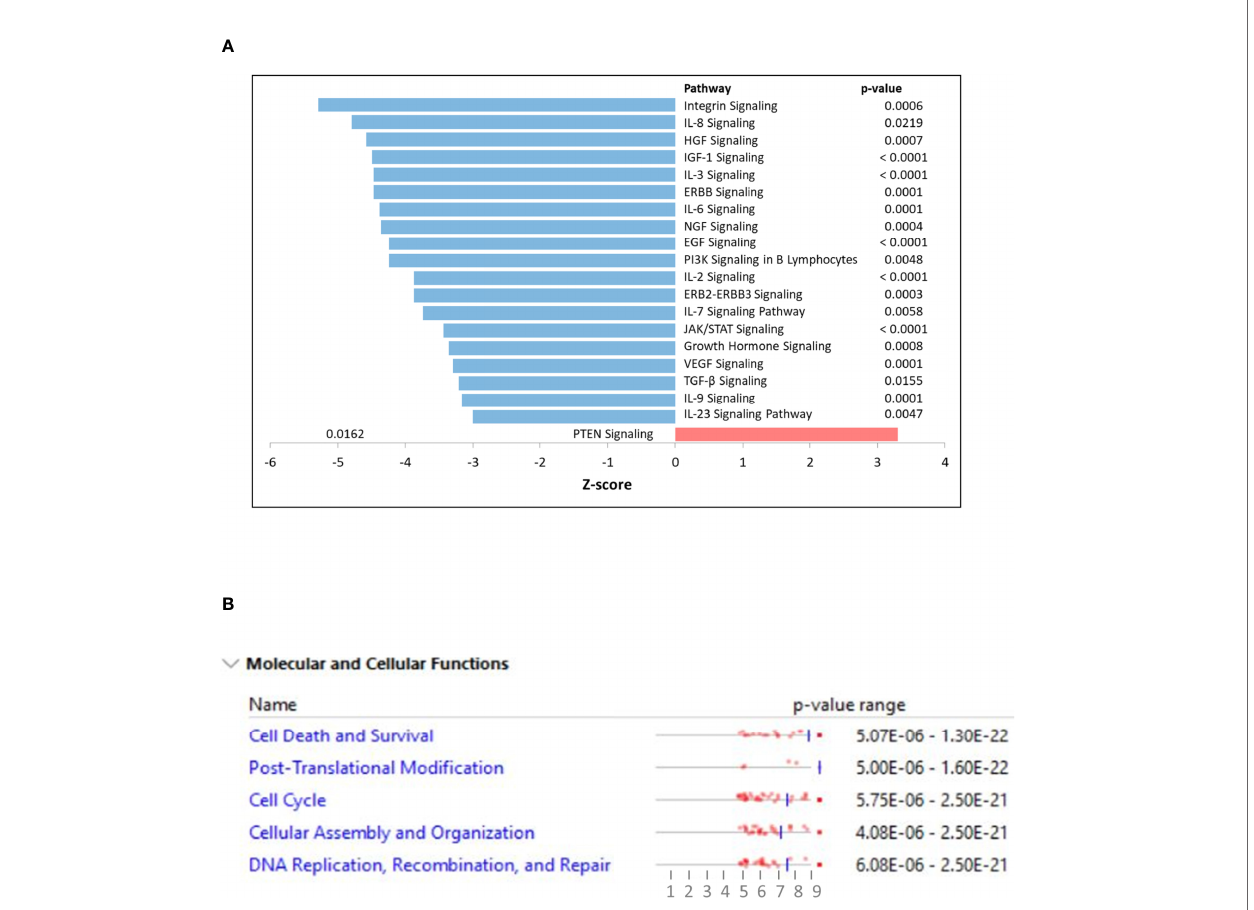
FIGURE 2 | (A) Ingenuity pathway analysis (IPA) displaying top affected signaling pathways with their z-scores. Positive z-score is predicted to be activated whereas negative z-score as inhibition of the pathway. (B) Ingenuity pathway analysis (IPA) displaying top affected molecular and cellular functions using differentially expressed genes as